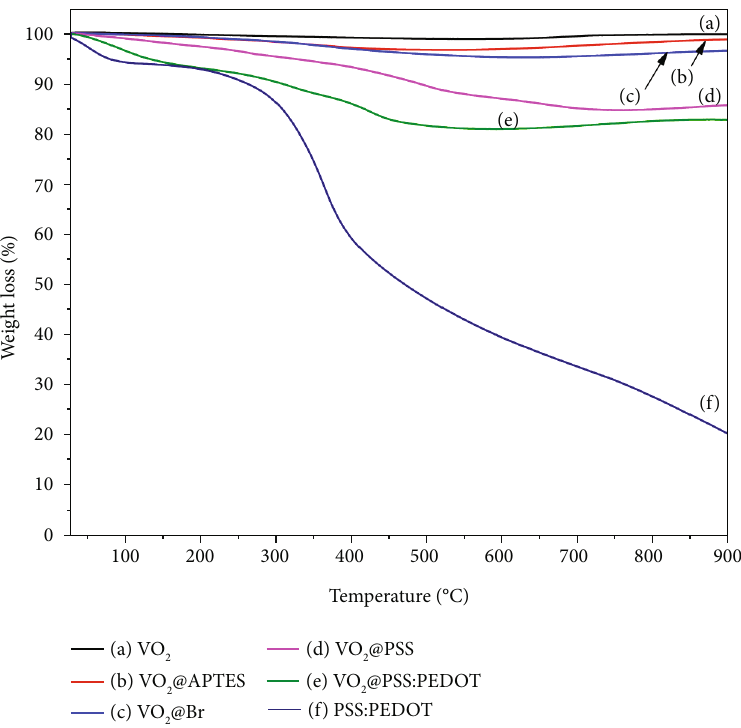
Figure 9: TGA thermograms of VO